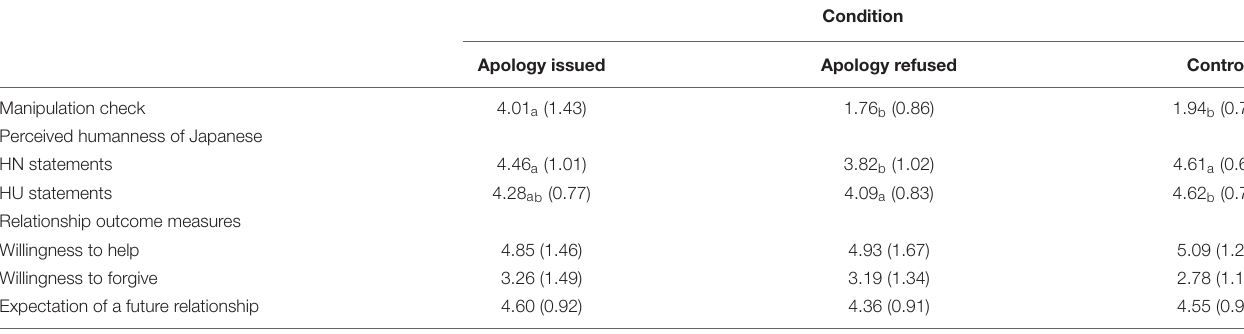
TABLE 2 | Means (standard deviations) of variables in the three experimental conditions (Study